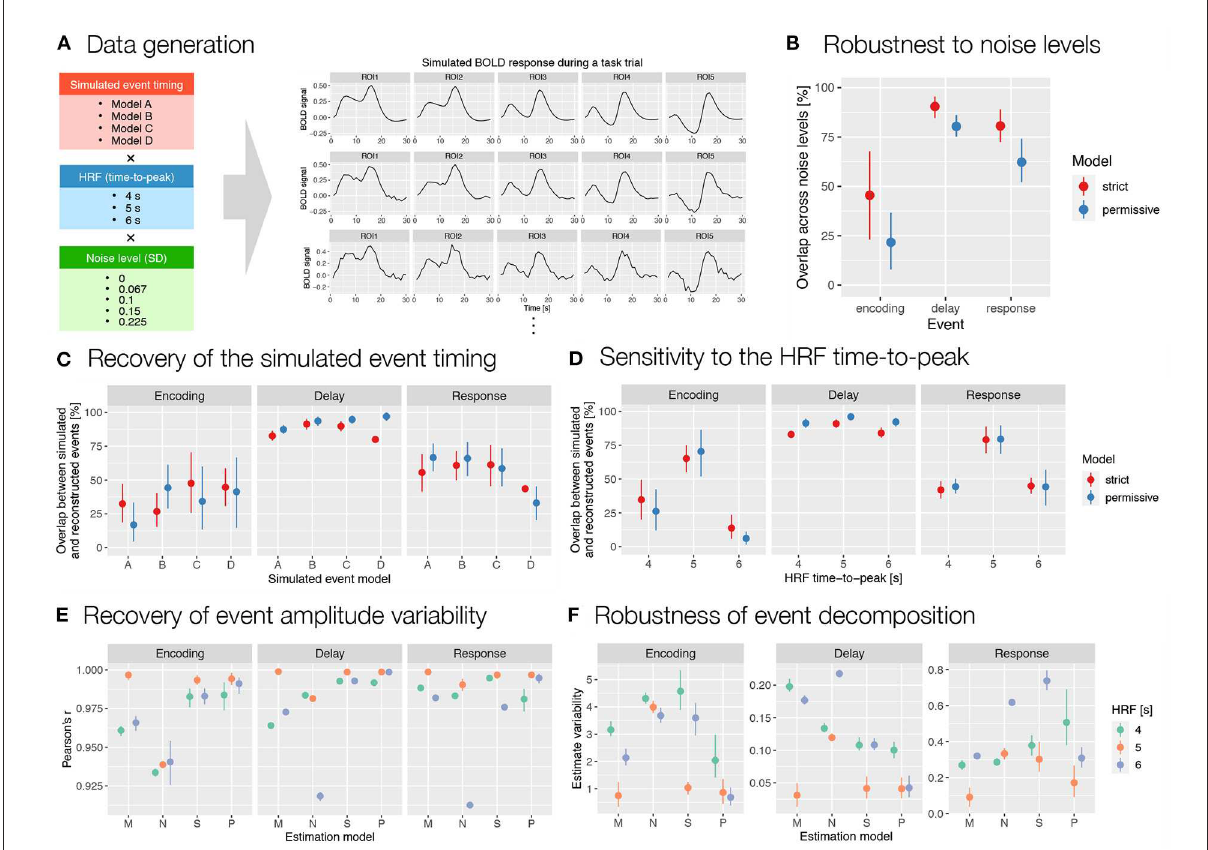
FIGURE6 Evaluation of the results obtained with autohrf based on simulated working memory fMRI data. (A) Simulated BOLD signal during a working memory task trial was computed as a convolution of predicted event time series and a double-gamma HRF. We prepared 60 simulations that differed in the predicted event timing ( encoding , delay , and response events with different onset and durations), HRF time-to-peak, and noise levels (i.e., added random Gaussian noise with different SD values). Each simulation was prepared based on 10 ROIs (only 5 are shown for schematic purposes) with different event amplitudes. We then ran the automated parameter search using autohrf with either strict or permissive constraints based on simulated BOLD signal. (B) The robustness of data-driven autohrf models to noise levels. The overlap was computed as the percentage of time covered by the automatically obtained event parameter across all noise levels, divided by the entire time range that included this event in at least one of five noise simulations, separately for each simulated event model and HRF timing. (C) The ability of autohrf to recover the simulated event timing based on four different models. The overlap was calculated as the percentage of the simulated event parameter covered by the automatically estimated event parameter. (D) The sensitivity of autohrf to differences in HRF time-to-peak. The overlap was calculated as the percentage of the simulated event parameter covered by the automatically estimated event parameter. (E) Pearson’s correlations between simulated event amplitudes and estimated β values using different estimation models (M–theoretical event model matching the simulated event model, N–theoretical event model not matching the simulated event model, S– autohrf -optimized model using strict constraints, P– autohrf -optimized model using permissive constraints). (F) The range of β estimates across ROIs in which the simulated event amplitude was constant when using different estimation models. The points show the means and the ranges show the 95 % confidence intervals computed with